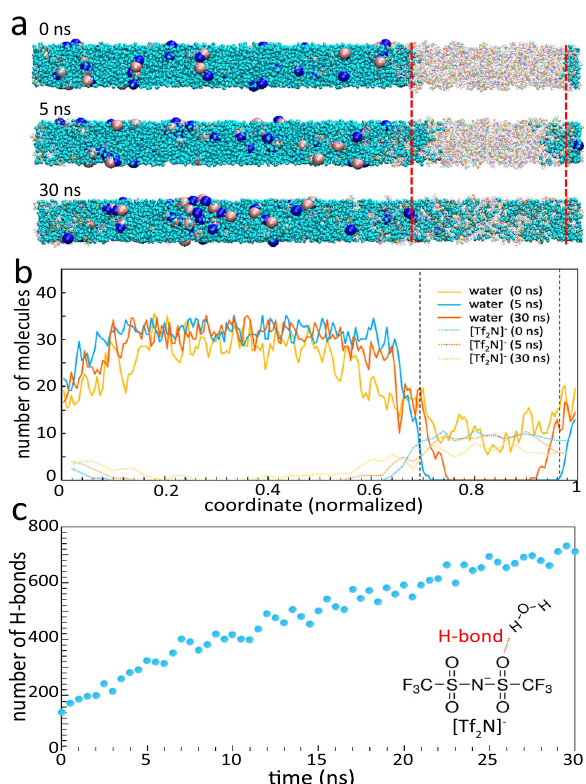
Fig. 4 MD simulation of the interface between IL and NaCl water solution (3.7%). a Snapshots of MD simulations at different times, where the blue block is water, red block is IL and large pink and dark blue spheres are respectively Cl − and Na + ions. b Density pro fi les of water and [Tf 2 N] − of the IL at different times corresponding to the snapshots in a . We note the [emim] + shows similar pro fi le as the [Tf 2 N] − and it is not plotted for clarity of the fi gure. c Number of hydrogen bonds (H-bonds) between [Tf 2 N] − and water molecules as a function of time.